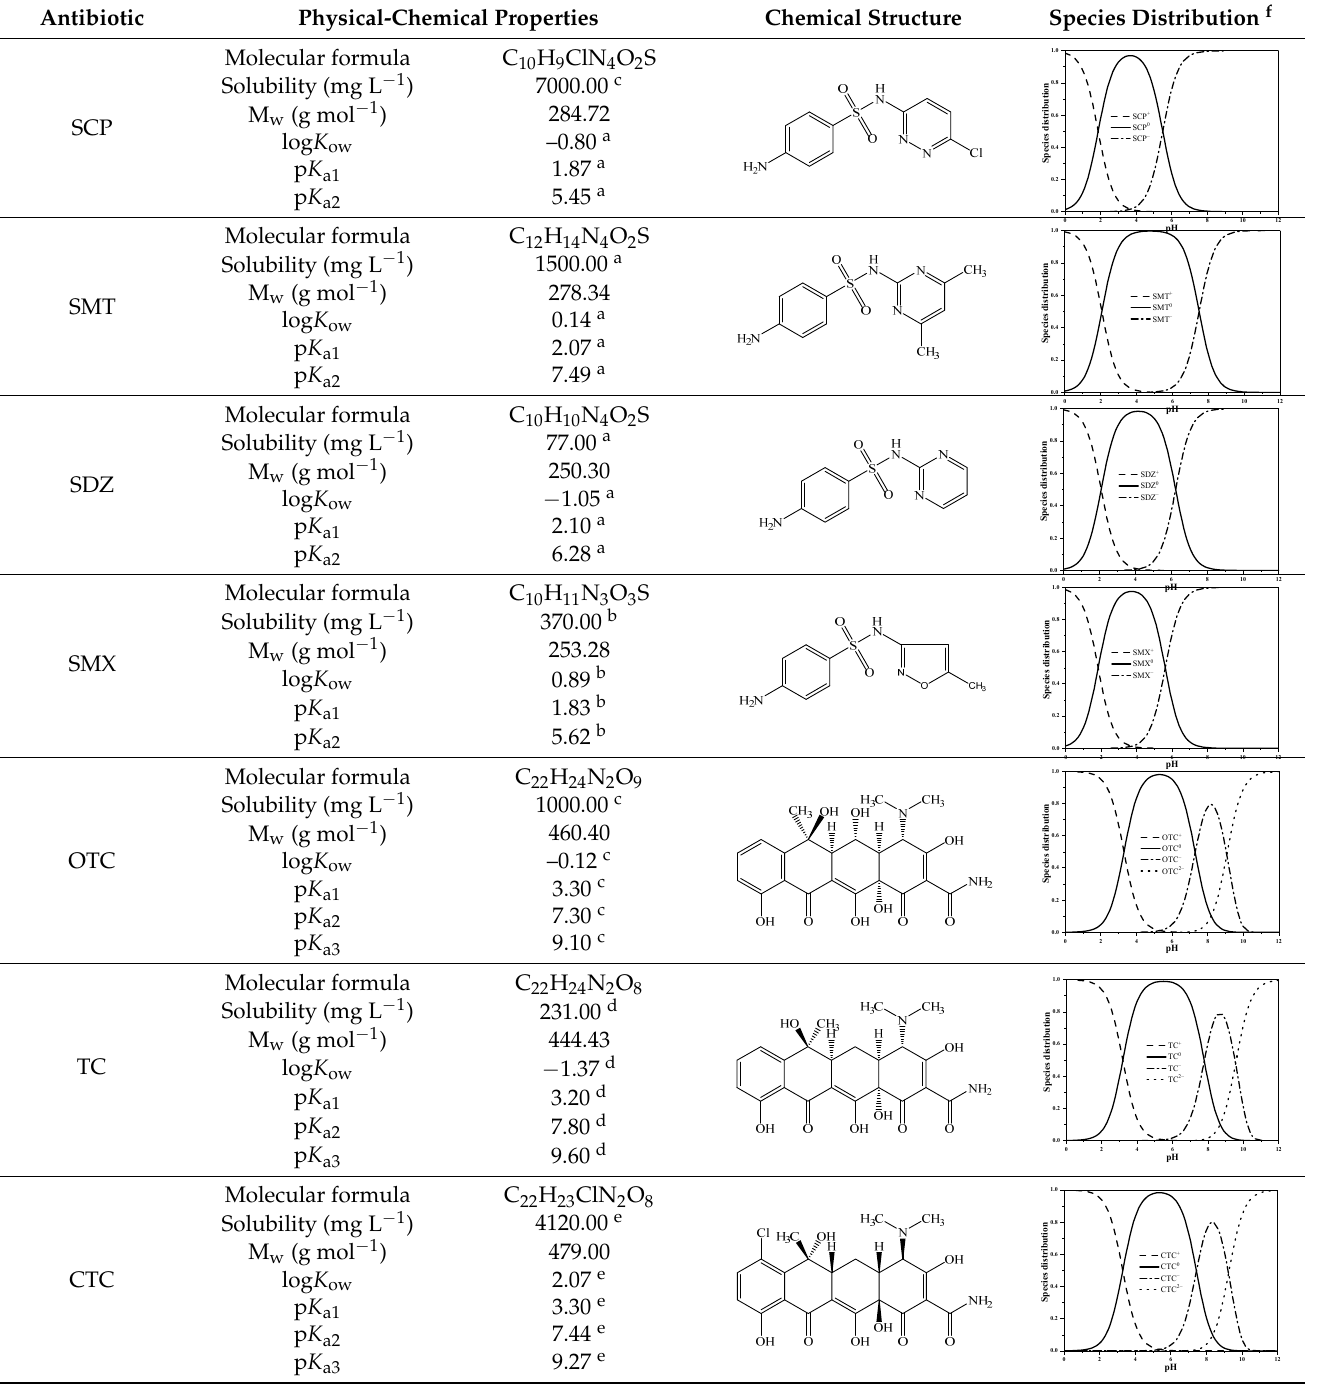
Table 1. Physicochemical properties of the target antibiotics.